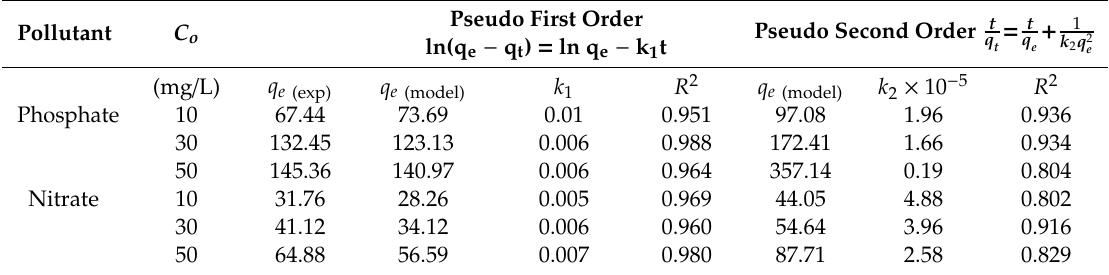
Table 3. Parameters of kinetic models for phosphate and nitrate adsorption onto B 5 MgAl composite.